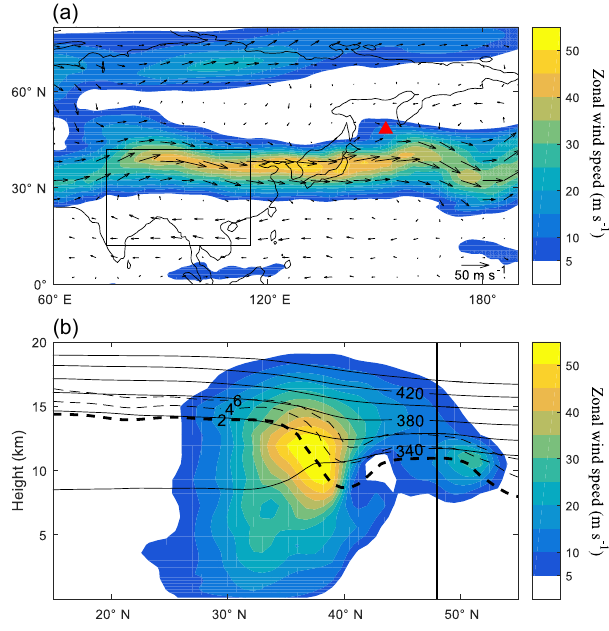
Figure 1. Meteorological conditions at the time of the Sarychev eruption (based on ERA–Interim reanalysis). (a) Zonal wind (shaded) and wind vectors on the 370K isentropic surface at 00:00UTC on 12 June 2009. The location of the Sarychev peak is denoted with a red triangle. The black rectangle indicates the area of the developing ASM anticyclone. (b) Vertical section of zonal wind (shaded) and contours of potential temperature from 340 to 440K (black solid lines) and potential vorticity from 2 to 6PVU (black dashed lines) along 153 ◦ E. The vertical black line denotes the latitude (48.1 ◦ N) of the Sarychev